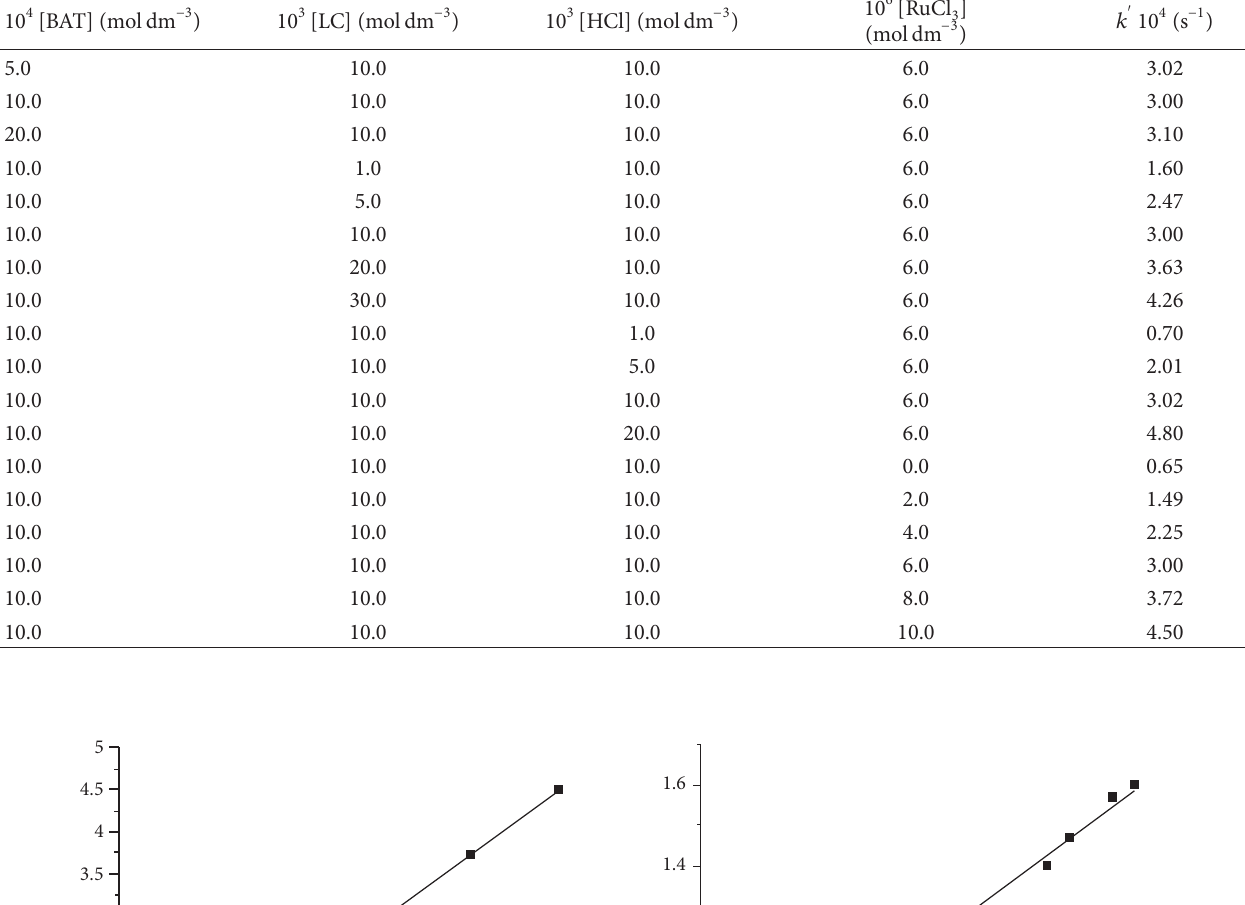
T 1: Effect of varying concentrations of oxidant, substrate, acid and Ru(III) on the reaction rate at 303K.